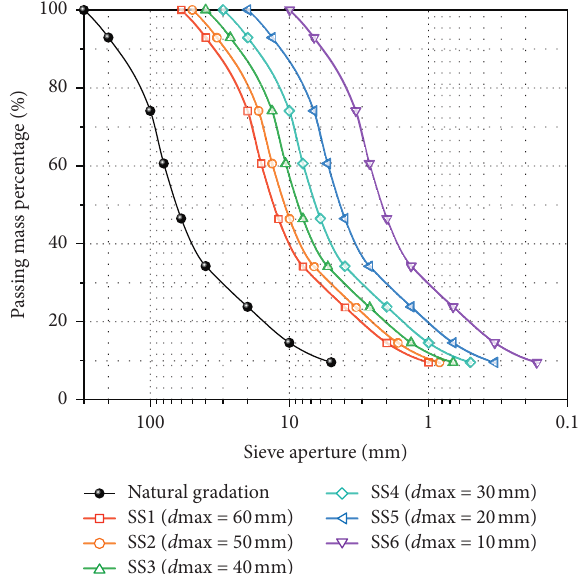
Figure 6: Grading curves of each scheme.